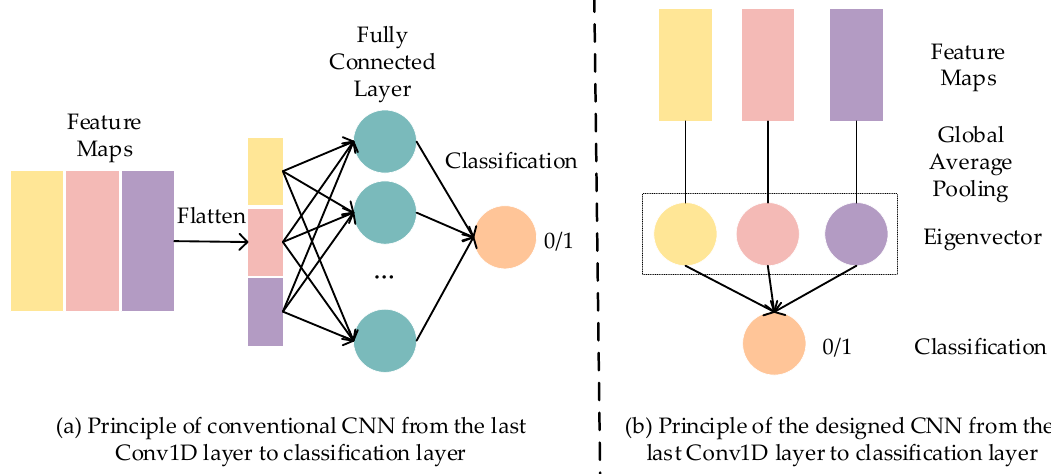
Figure 3. Comparison of the working principle between a fully connected layer and the global average pooling layer. “0” and “1” denote abnormal and normal heart sounds, respectively. The feature maps are generated by the convolution layers of the last Conv-block. ( a ) Description of the workflow from feature maps to the classification layer. The feature maps should first be flattened in this process. ( b ) Description of the principle of the global average pooling layer.